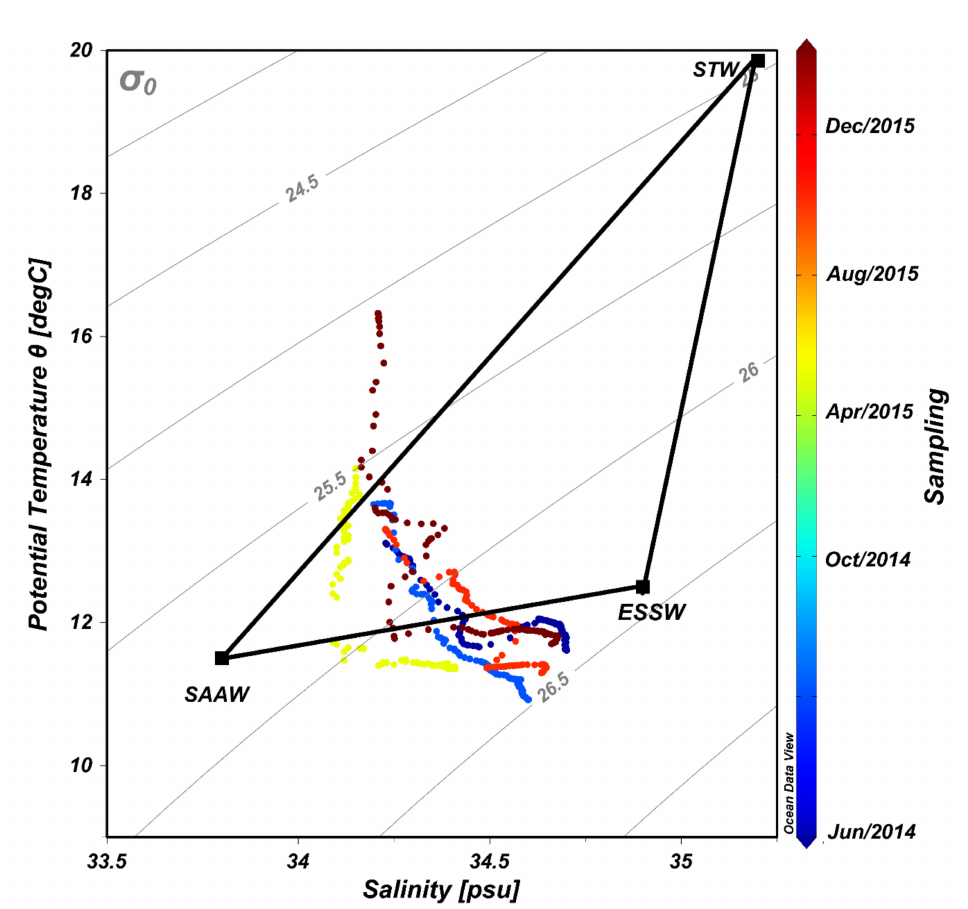
Figure 2. Temperature and salinity (T/S) diagram indicating the contribution from different water masses, i.e., sub-Antarctic Waters (SAAW), Equatorial Subsurface Waters (ESSW) and Subtropical Waters